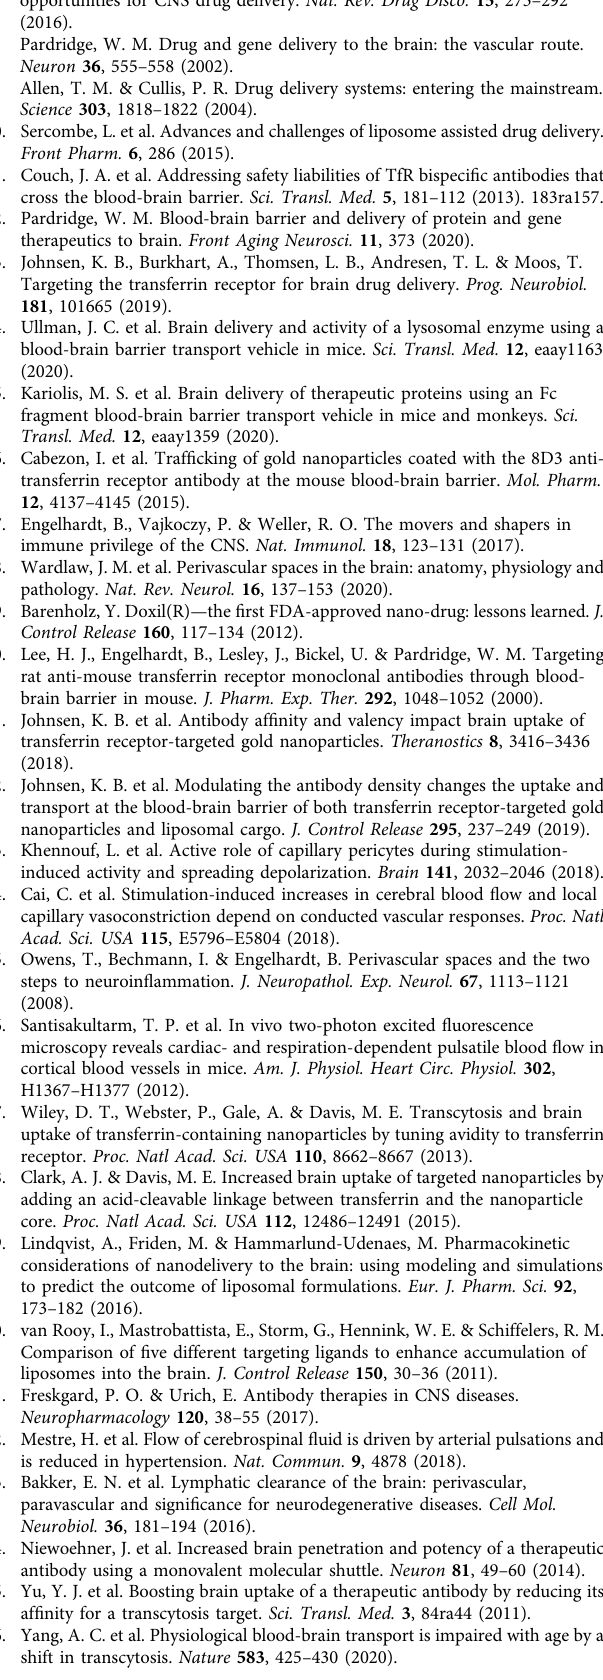
Fig. 1d n = 2; Supplementary Fig. 2a – d n = 2; Supplementary Fig. 3a n = 5. Sup- plementary Fig. 3b – e n = 2. Images from single experiments were included to illustrate the lack of targeting properties of nanoparticles without TfR-targeting antibody, i.e., in Supplementary Fig. 1f, g n = 1; Supplementary Fig. 1h, i n = 1; Supplementary Fig. 2e n = 1; Supplementary Fig. 4 n = 1